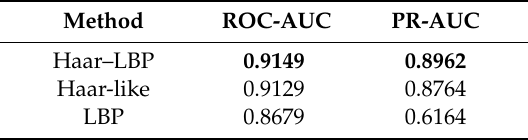
Table 3. Comparison result of the same testing set in precision, recall and accuracy.